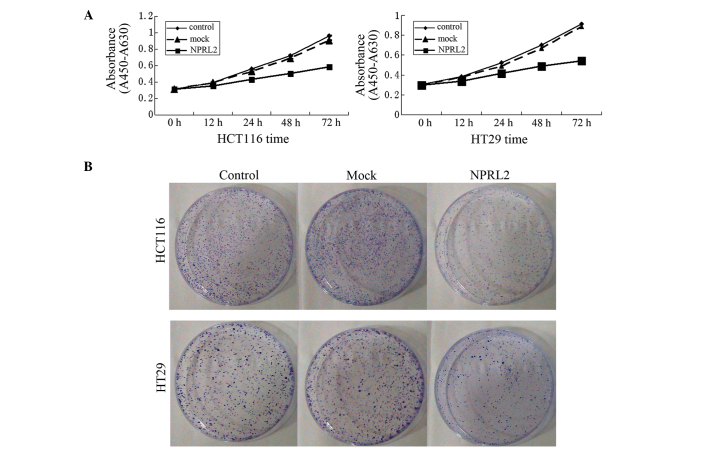
Inhibition of growth by the overexpression of NPRL2. (A) Cell proliferation curves, determined using Cell Counting Kit-8 assays. (B) Colony formation assay, in which 1×103 cells were seeded into six-well plates and cultured in RPMI 1640 for 2 weeks. The colonies were then stained with Giemsa, counted and images were captured. Control, cells without transfection; mock, cells transfected with mock vector; NPRL2, cells transfected with NPRL2-overexpression vector. NPRL2, nitrogen permease regulator-like-2.